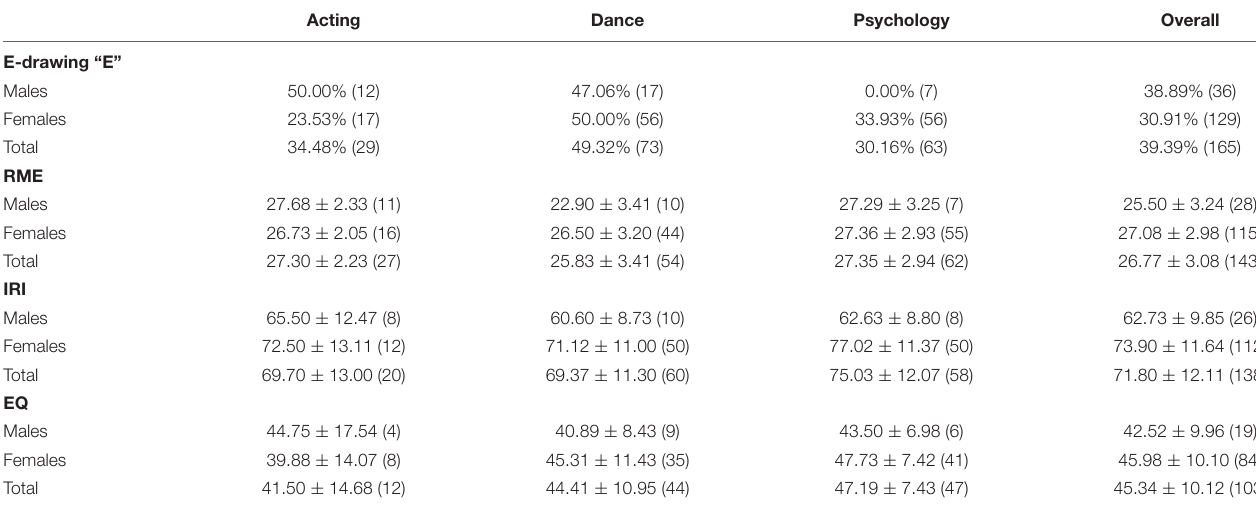
TABLE 1 | Average scores ± Standard Deviation for each test after outlier